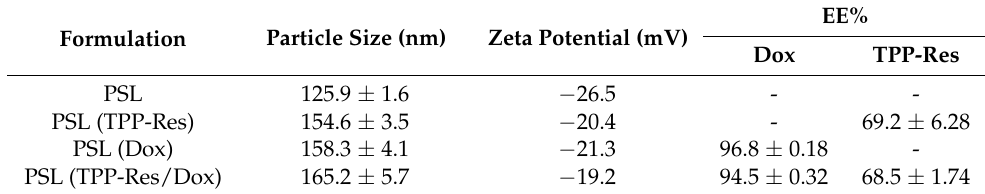
Figure 2. ( a ) Transmission electron microscope image and particle size distribution of different liposomes. ( b ) In vitro drug release of Dox and TPP-Res from PSL (Dox/TPP-Res) in PBS (pH 7.4, 6.5, 5.0). All data are expressed as mean values ± SD of 3 independent experiments. Table 1. Characterization of different